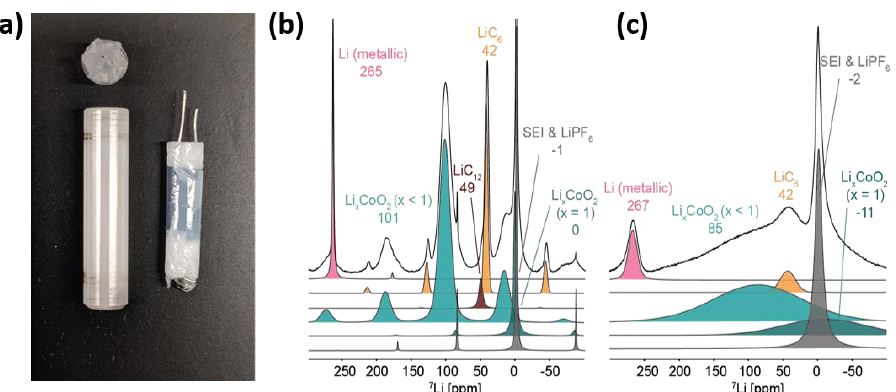
Figure 7. ( a ) Commercial 4 mm NMR rotor (left) and assembled jelly-roll battery insert (right). Deconvolution of the 7 Li NMR spectra of a fully charged LiCoO 2 / graphite cell under ( b ) magic angle spinning (MAS) speed of 10 kHz and ( c ) static conditions. (Reproduced with permission from [82]; Copyright 2019 American Chemical Society.